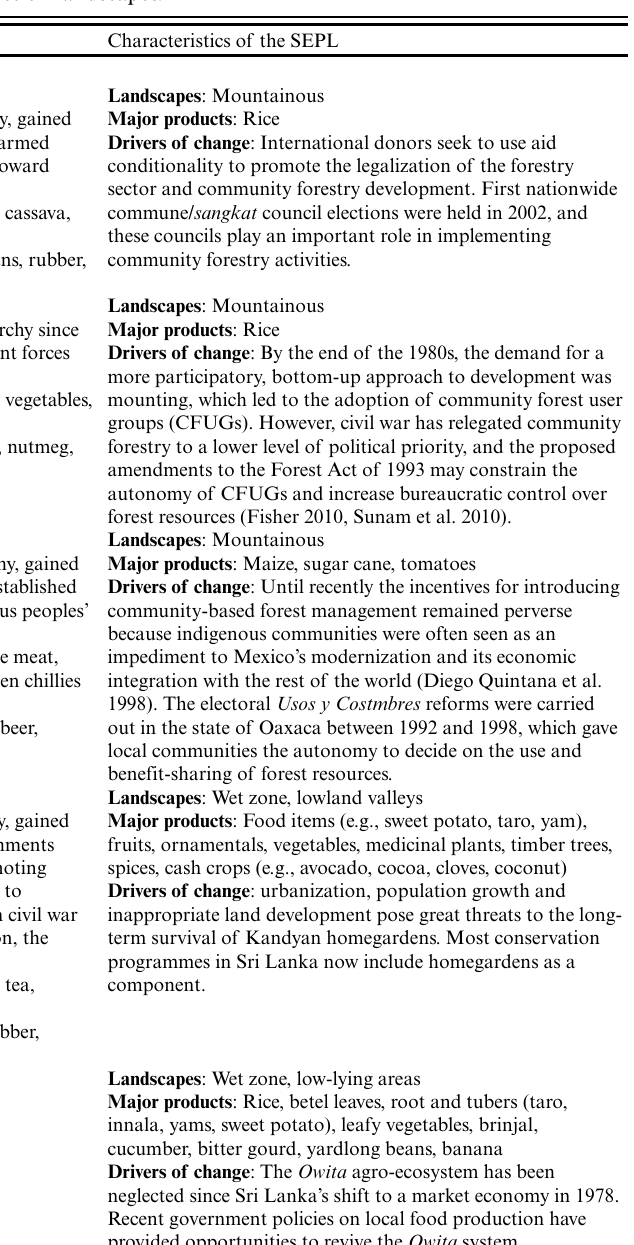
Table 1 . Overview of case studies. SEPL = socio-ecological production